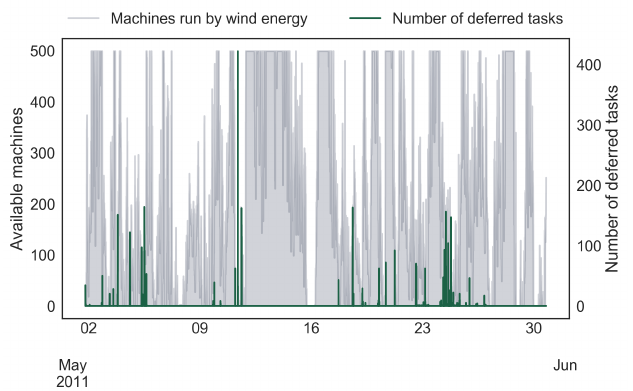
Figure 4. Number of deferred tasks and available machines running fully on wind energy, for the unaltered trace. The pattern is similar for the unaltered